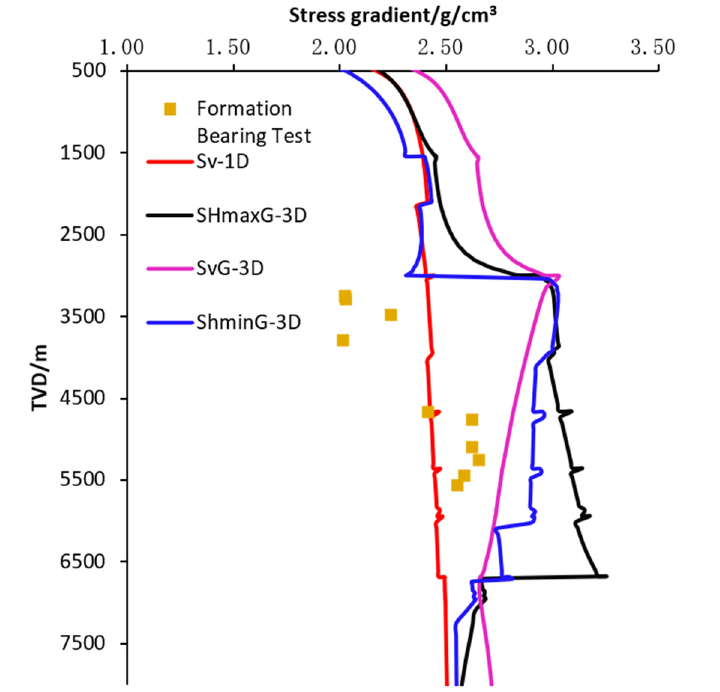
Figure 9. Stress gradient as a function of vertical depth at well LT ‐ 1.